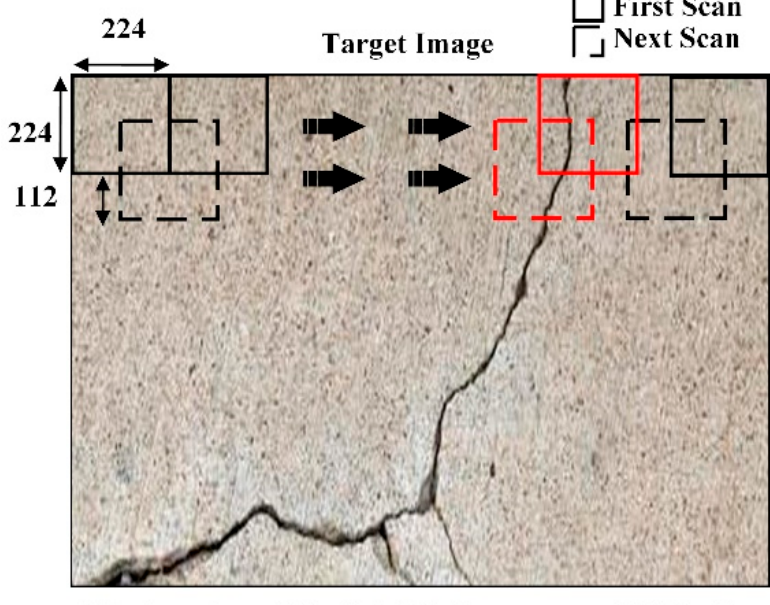
Figure 10. Representation of sliding window approach.